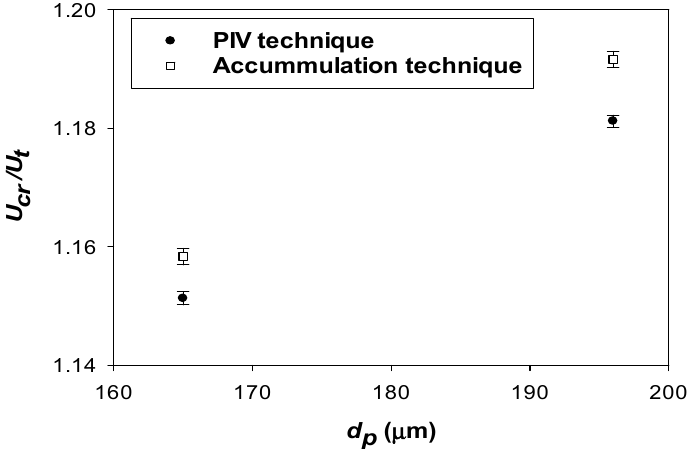
Figure 7. Normalised critical transition velocity as a function of particle size obtained from the PIV and accumulation measurement technique.